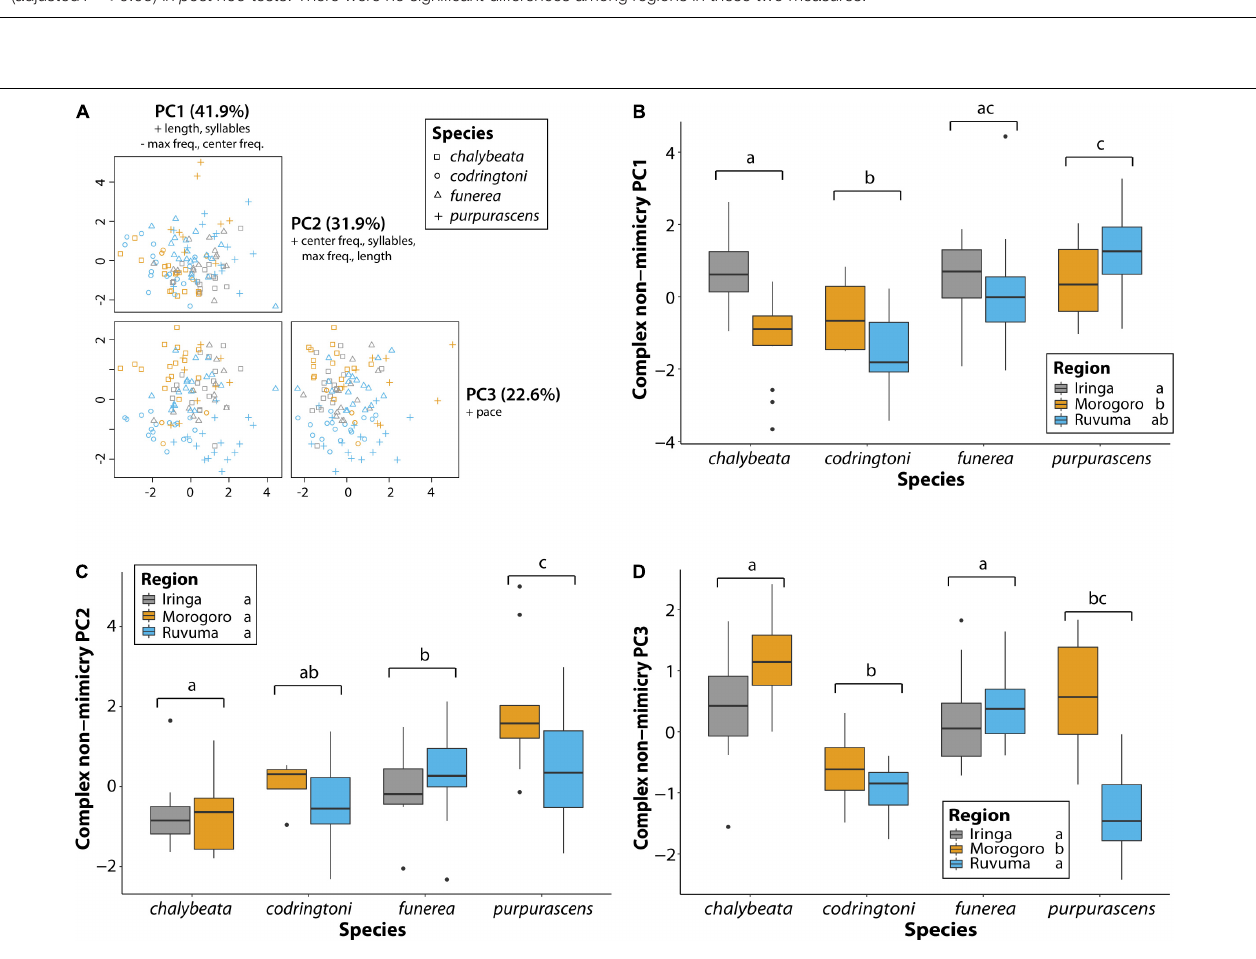
FIGURE 4 | Variation in (A) size and (B) diversity of non-mimicry song repertoires among indigobird species and sampled regions. Populations of the same species are grouped on the X -axis; boxplots are color-coded by sampling region. Species labeled with different lowercase letters (above brackets) differed significantly (adjusted P < 0.05) in post hoc tests. There were no significant differences among regions in these two measures.